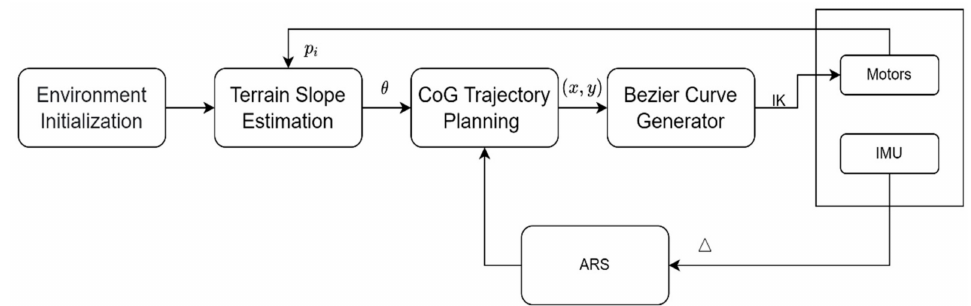
Figure 1. Algorithm